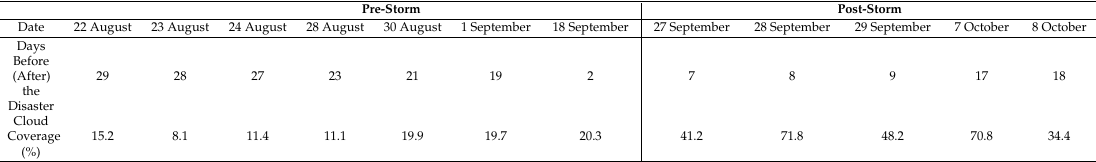
Table 6. The dates and cloud coverages of pre- and post-storm DNB images of Hurricane Maria.